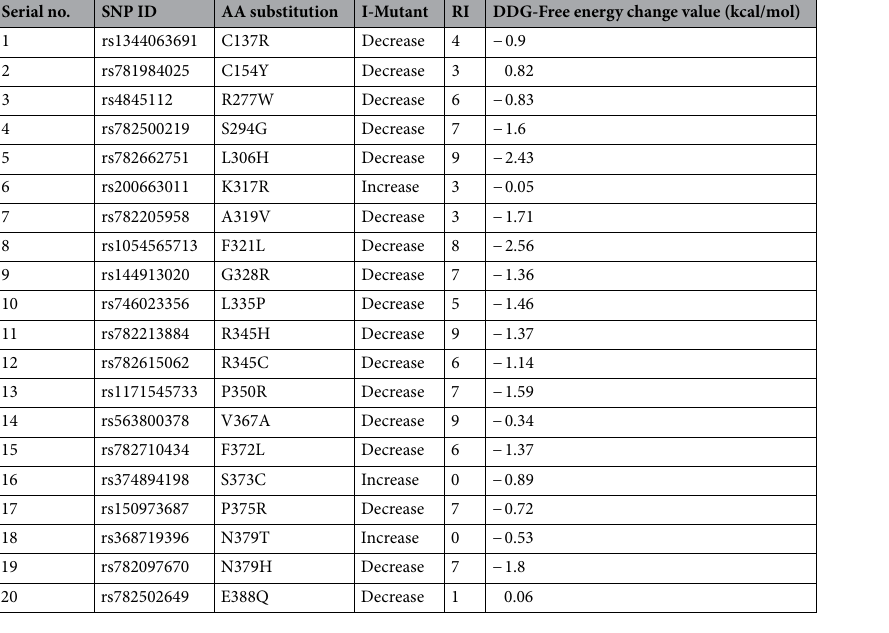
Table 2. Effect of nsSNPs on protein stability predicted by I-MUTANT